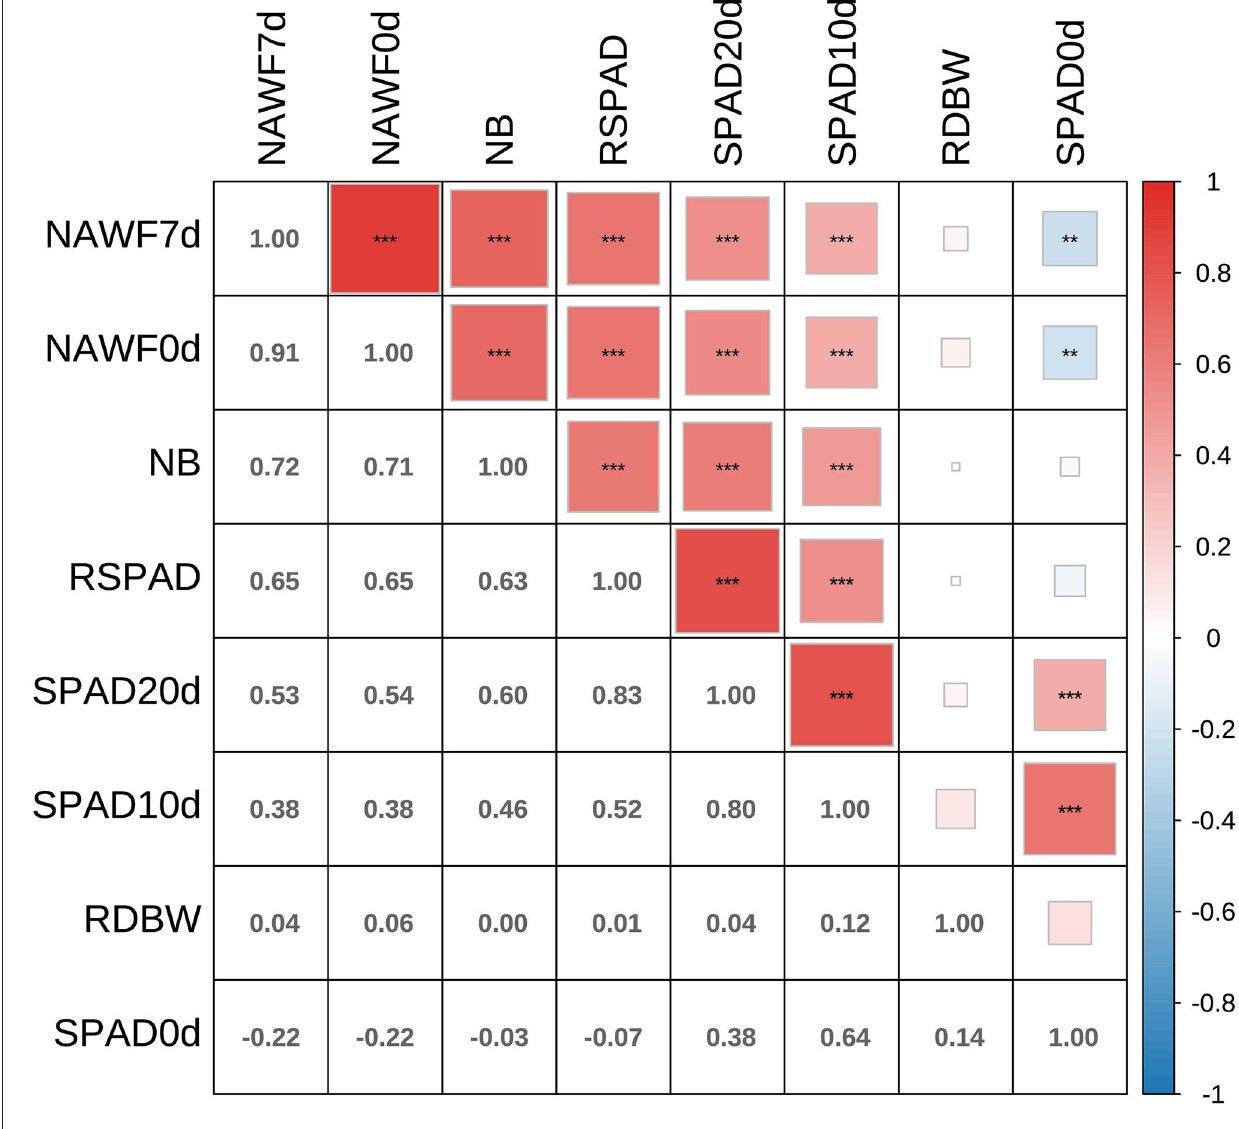
FIGURE 2 | Correlation analyses between eight senescence-related traits. Asterisks indicate significance levels (*** P < 0.001, ** P < 0.01, and * P <